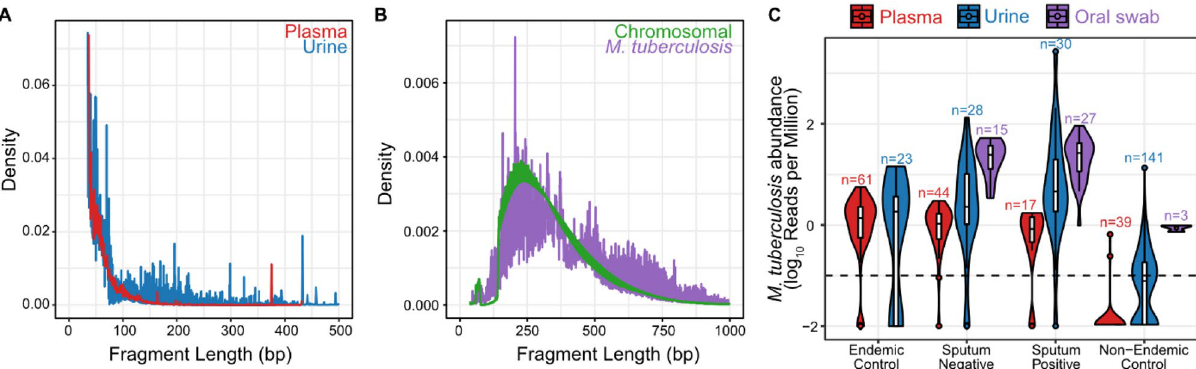
Figure 2. ( A ) The fragment length distributions of M. tuberculosis DNA in plasma (red) and urine (blue). ( B ) The fragment length distribution of M. tuberculosis DNA (purple) and host chromosomal DNA (green) in oral swabs are similar, suggesting that the microbial DNA is genomic and the fragmentation profile is not an intrinsic property but rather the consequence of sample preparation steps. ( C ) The abundance of M. tuberculosis DNA across all cohorts and biofluids. The majority of non-endemic samples have little to no detectable M. tuberculosis DNA, while the abundance of M. tuberculosis DNA in endemic and tuberculosis samples increases from plasma to oral swab. Dashed line indicates a limit of detection cutoff of 0.1